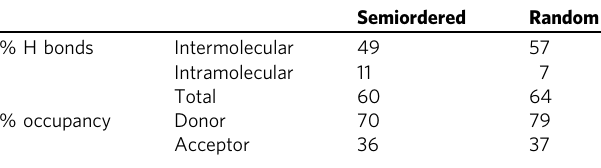
Each type of H bond is illustrated in Fig.